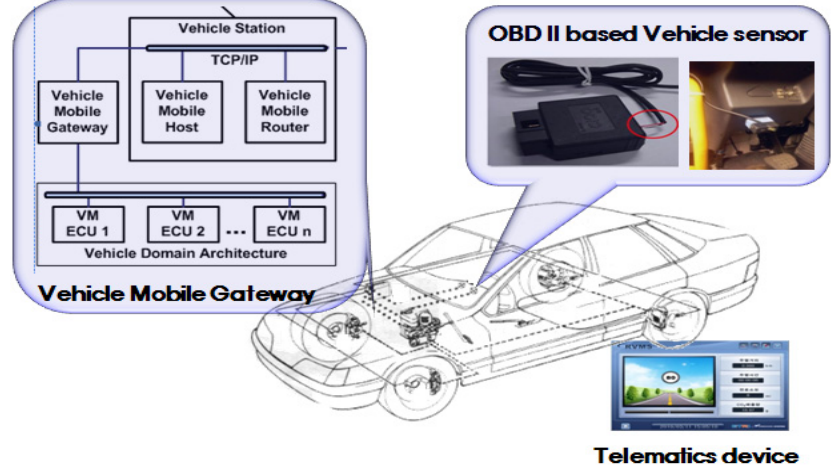
Figure 3. OBDII-based vehicle